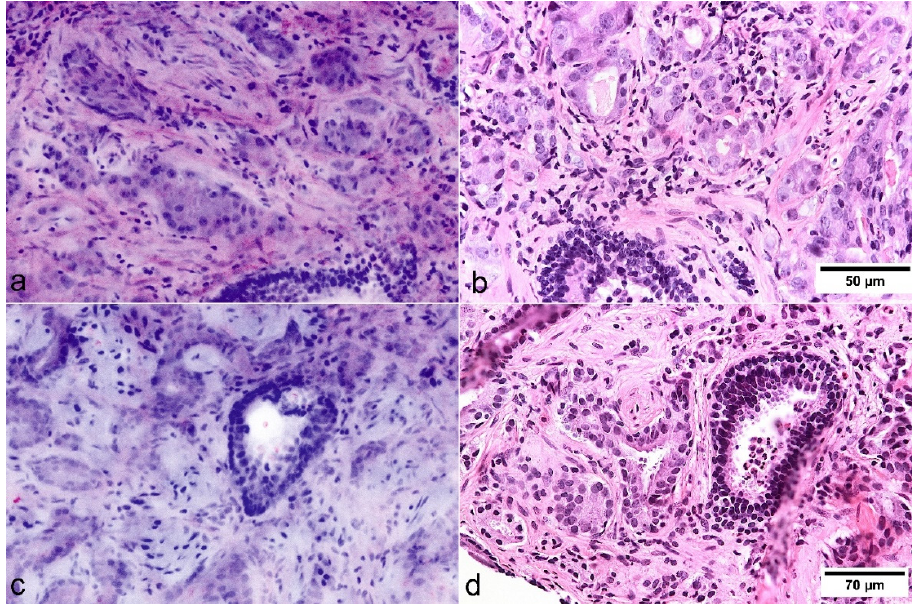
Figure 3. Cytologic criteria of prostate carcinoma in FCM images (left) and FFPE slides (right). ( a , b ) The basal cell layer can be identified in pre-existing benign glands. In this case, nuclear enlargement and prominent nucleoli could be easily identified in FCM scans. ( c , d ) In this case, nucleolar enlargement and prominent nucleoli are not presented as distinctly in the FCM as in the HE slides.